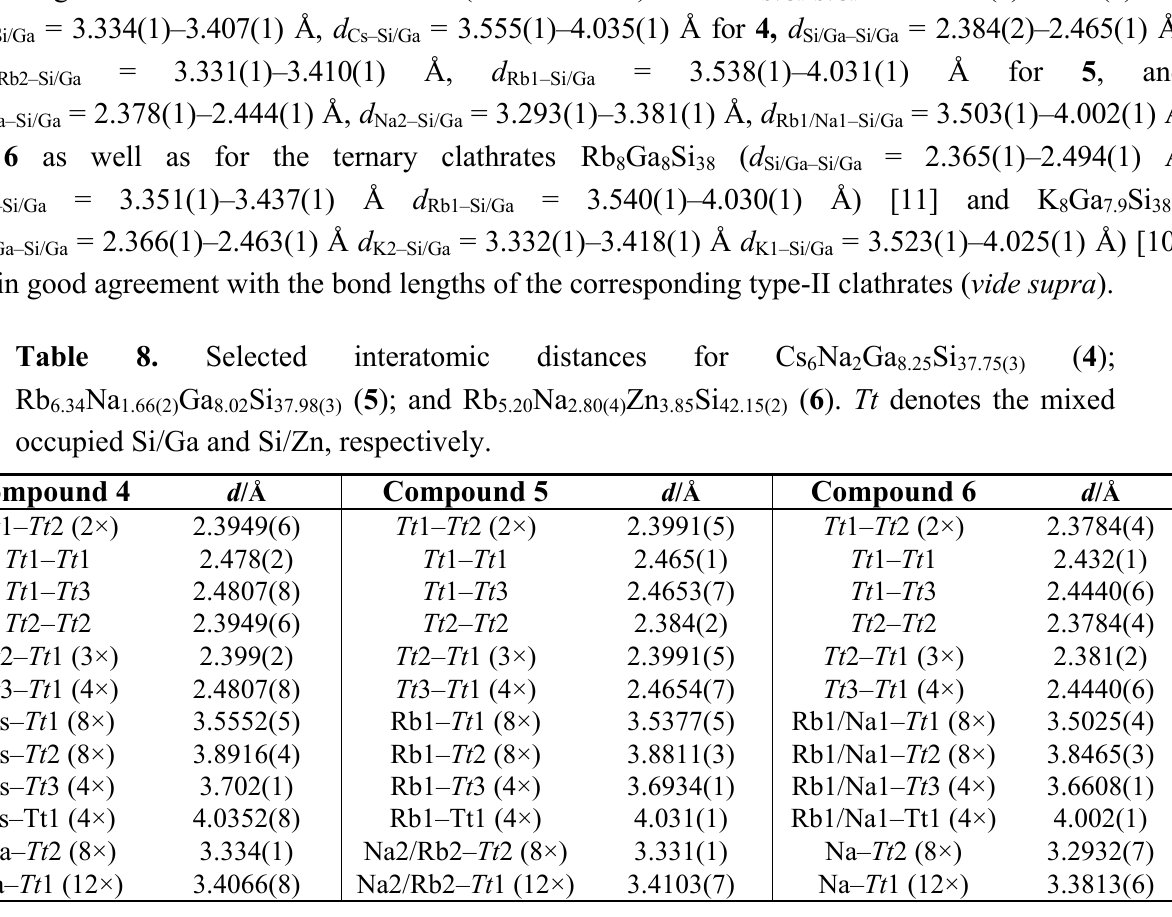
Figure 4. Representation of the polyhedral cages in the type-I structures with anisotropic displacement parameters, drawn at the 95% probability level. ( a ) Cs